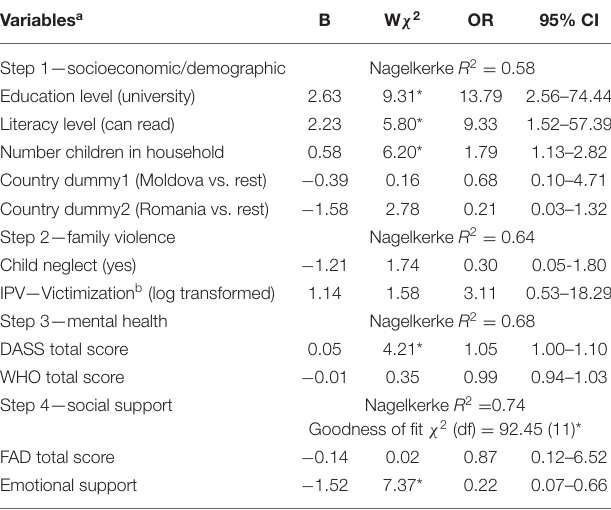
TABLE 4 | Hierarchical logistic regression for the experience of hunger (i.e., at least one form of hunger in the past month) and four sets of risk factors. Variables